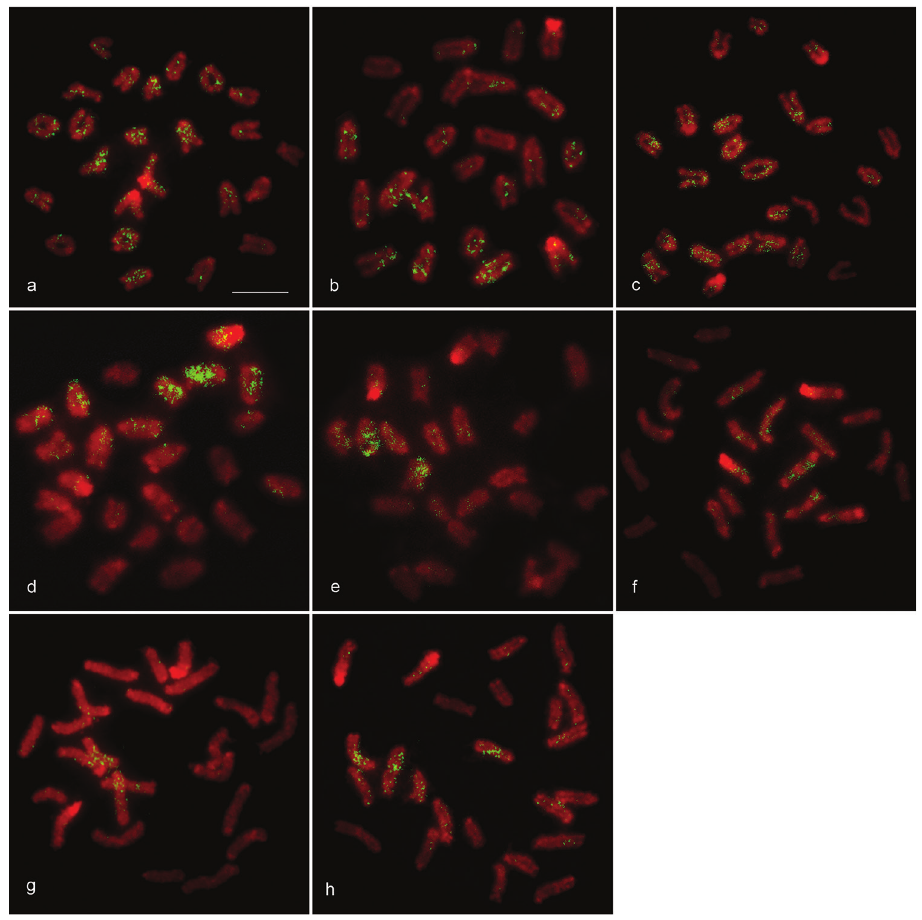
Figure 3. Chromosomal locations of microsatellite repeat motifs in Monopterus albus . Hybridization pat- tern of FITC-labeled (CAA) ( a ), (CAG) ( b ), (CGG) ( c ), (GAG) ( d ), (AGAT) ( e ), (ACGC) ( f ), 10 10 10 10 8 8 (AAAT) ( g ), and (AAATC) ( h ) on PI-stained chromosomes. 8 6 and Notothenia coriiceps Richardson, 1844 (Perciformes) and the maximum divergence of 41.95% to Poeciliopsis gracilis Heckel, 1848 (Cyprinodontiformes); the average is 24.51±8.14%. The phylogenetic placement of Rex1 sequences showed that most species were grouped in their respective orders (Fig. 6, Suppl. material 6). The average K /K s a value of Rex1 sequences was 2.19±0.08 (Table 1). The nucleotide sequence of a 415 bp- fragment of MALRex3 was used in multiple sequence alignment with 24 other teleosts, showing 23 indels. The average sequence divergence among species was 33.94±17.24%, ranging from 2.65% to 69.54% (Suppl. material 4). MALRex3 sequences showed the minimum interspecific sequence divergence of M. albus , 18.54%, from Esox lucius Linnaeus, 1758 (Esociformes) and the maximum divergence, 66.65%, from Astyanax fasciatus Cuvier, 1819 (Characiformes); average 31.84±12.74%. The